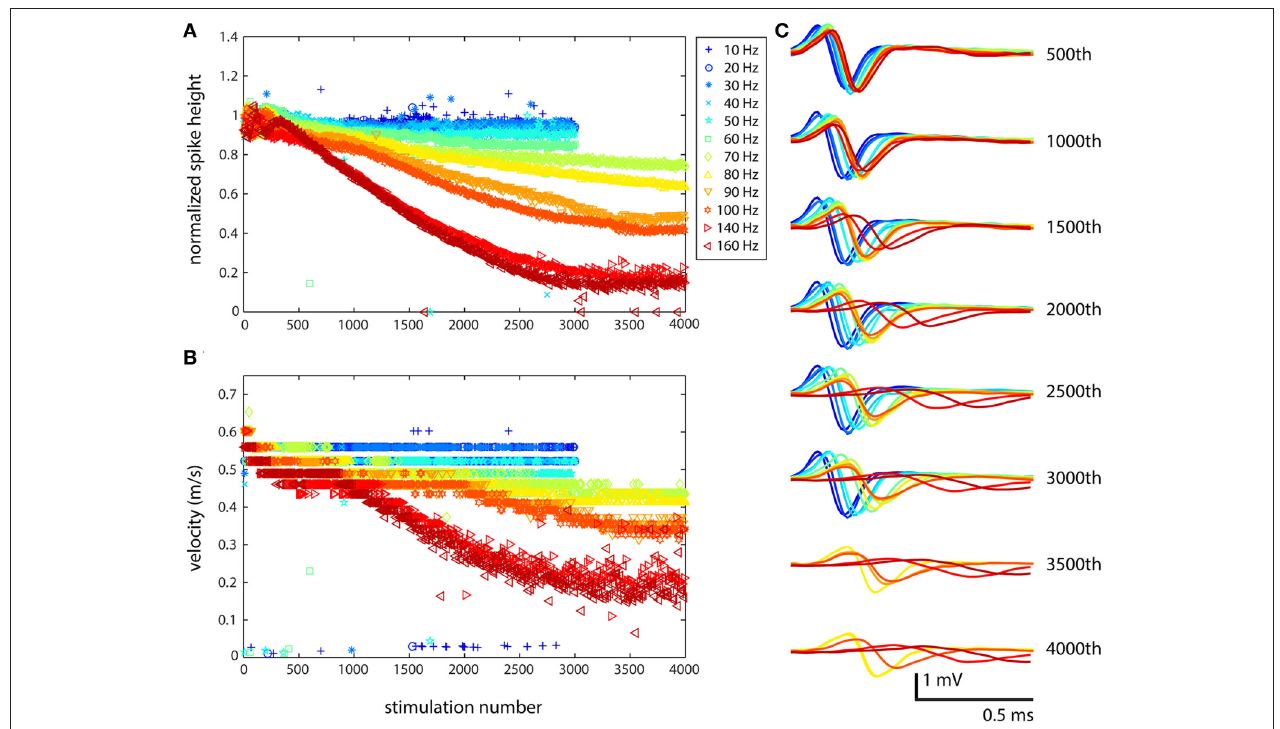
FIGURE 2 | Stimulation at medium to high frequencies results in highly altered axonal waveforms. The cell was stimulated from 10 to 160Hz, and because of the large waveforms in the channels, it was possible to very clearly observe the changes in waveform. (A) Large effects to the spike shape resulting from stimulation were not observed until stimulation at 80Hz (yellow). At higher frequencies and following a larger number of stimulations, the effects were more dramatic. (B) Propagation velocity was also affected by stimulation: propagation slowed down at higher frequencies. (C) The change in shape of the waveform from top (500th stimulation) to bottom (4000th stimulation) shows the stereotypical behavior: decrease in spike height, increase in spike width, and increase in latency. The electrode from which these data were recorded is designated in Figure 1B with a black asterisk. Similar results were obtained for all electrodes in channels that were recorded from. Color corresponds to stimulation